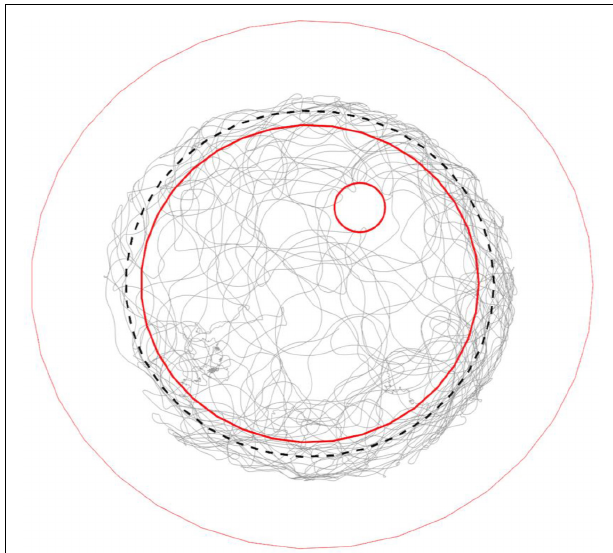
FIGURE 4 | Typical trajectory of a walking bumble bee (#140409) in the arena. Gray lines show the trajectory of a full recording (28 min). The three red open circles from big to small mark the borders of the plate rim, ground paper and feeding disk, respectively. The black dashed-line circle marks the invisible lower end of slope. The bee fully explored the ground area, tried to escape from the slope during thigmotactic walking and visited the feeding place occasionally.